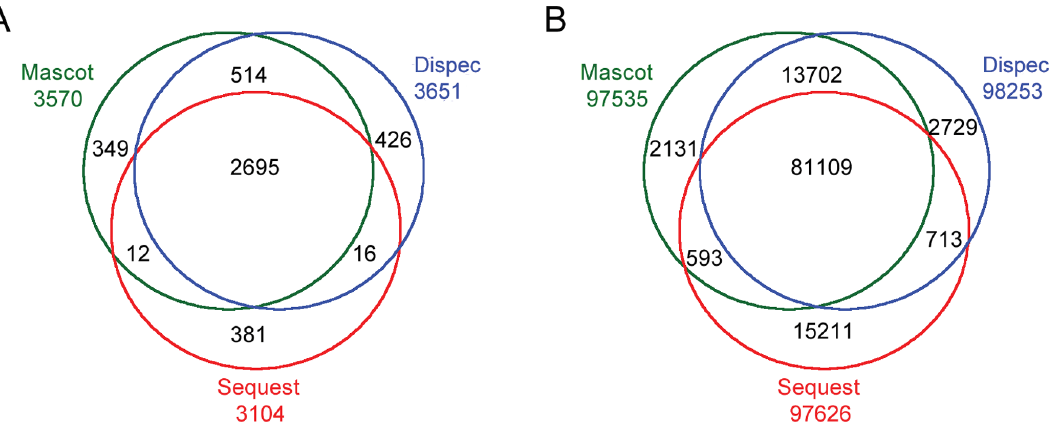
Figure 2. Comparison of Mascot, Sequest and Dispec using S.pneumoniae D39 dataset. (A) Number of identified peptides. (B) Number of identified spectra.